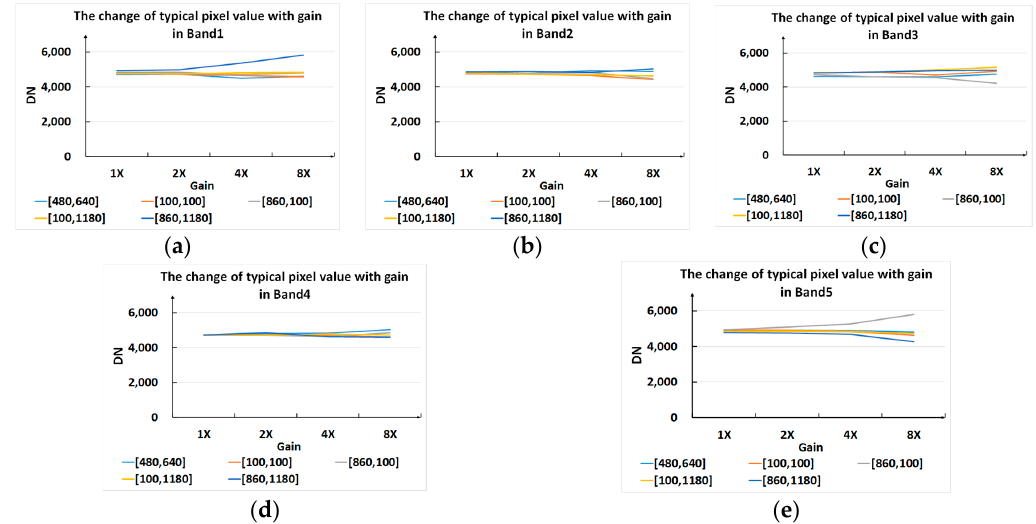
Figure 5. Variation in the typical pixel value with gain for: ( a ) Band1; ( b ) Band2; ( c ) Band3; ( d ) Band4; ( e )